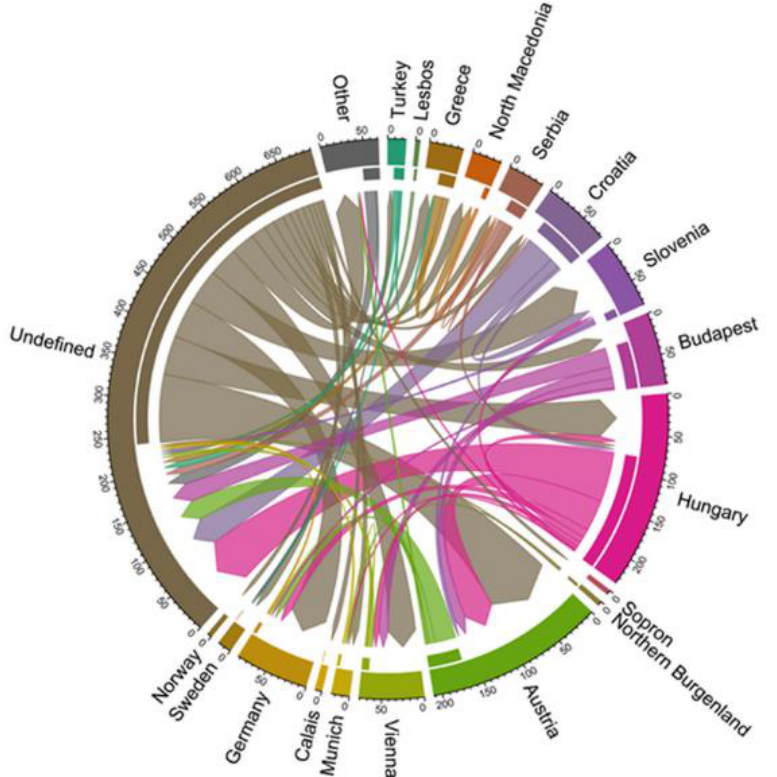
Figure 19. Chord diagram showing the flow of refugees across the Balkan route (number of tweets).